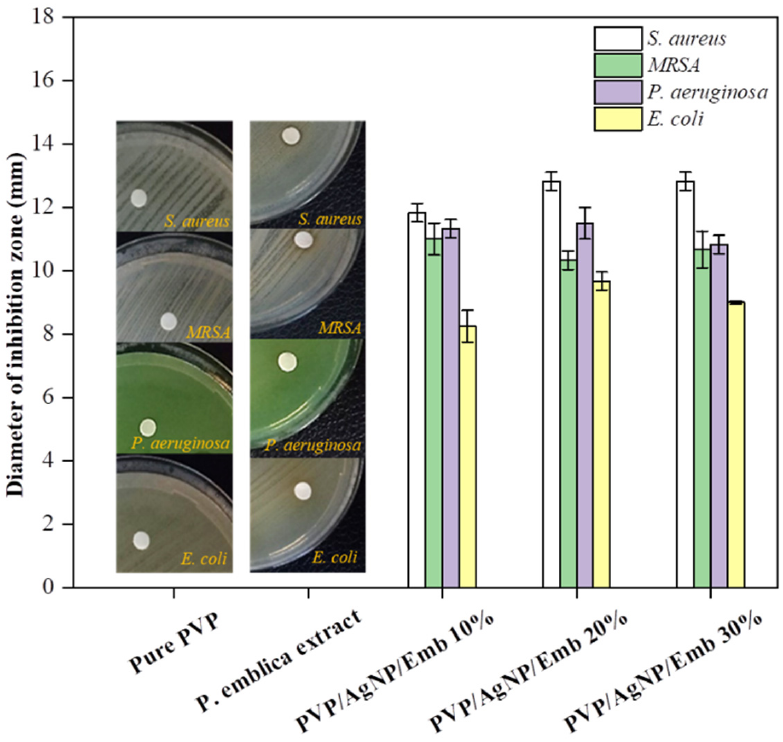
Figure 9. Antibacterial activity of PVP, Phyllanthus emblica extract, and Phyllanthus emblica extract- loaded spray-on dressing films against S. aureus , MRSA, P. aeruginosa, and E. coli .